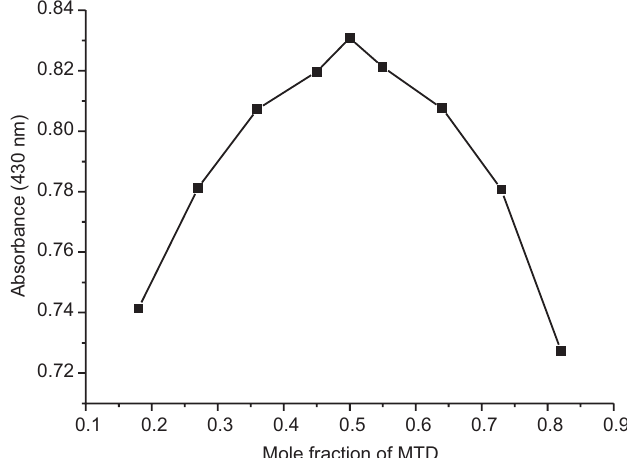
FIGURE 5 - Continuous variation plot for MTD with sodium